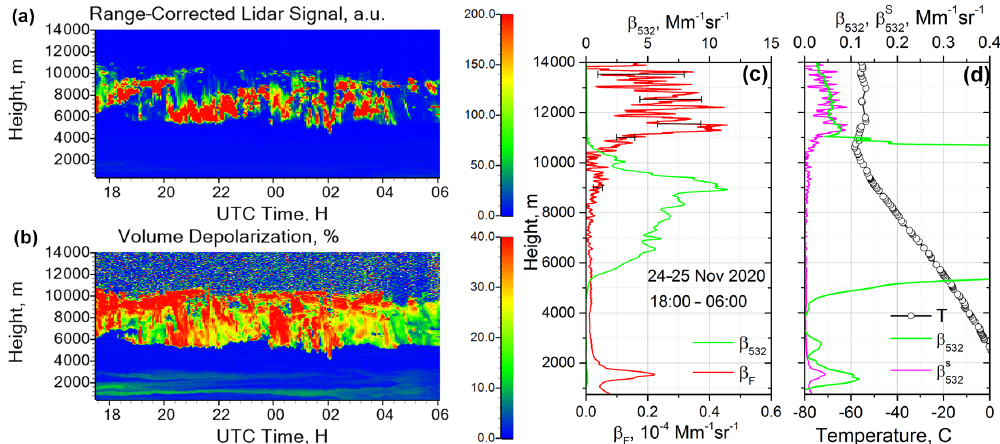
Figure 3. Smoke fluorescence in the presence of clouds on 24–25 November 2020. (a, b) Spatiotemporal variations in the range-corrected lidar signal and volume depolarization at 1064nm. (c) Vertical profiles of the aerosol β 532 and fluorescence β F backscattering coefficients. (d) Aerosol backscattering coefficient β 532 , together with smoke backscattering coefficient β s Open symbols show temperature profile measured by the radiosonde at Herstmonceux.